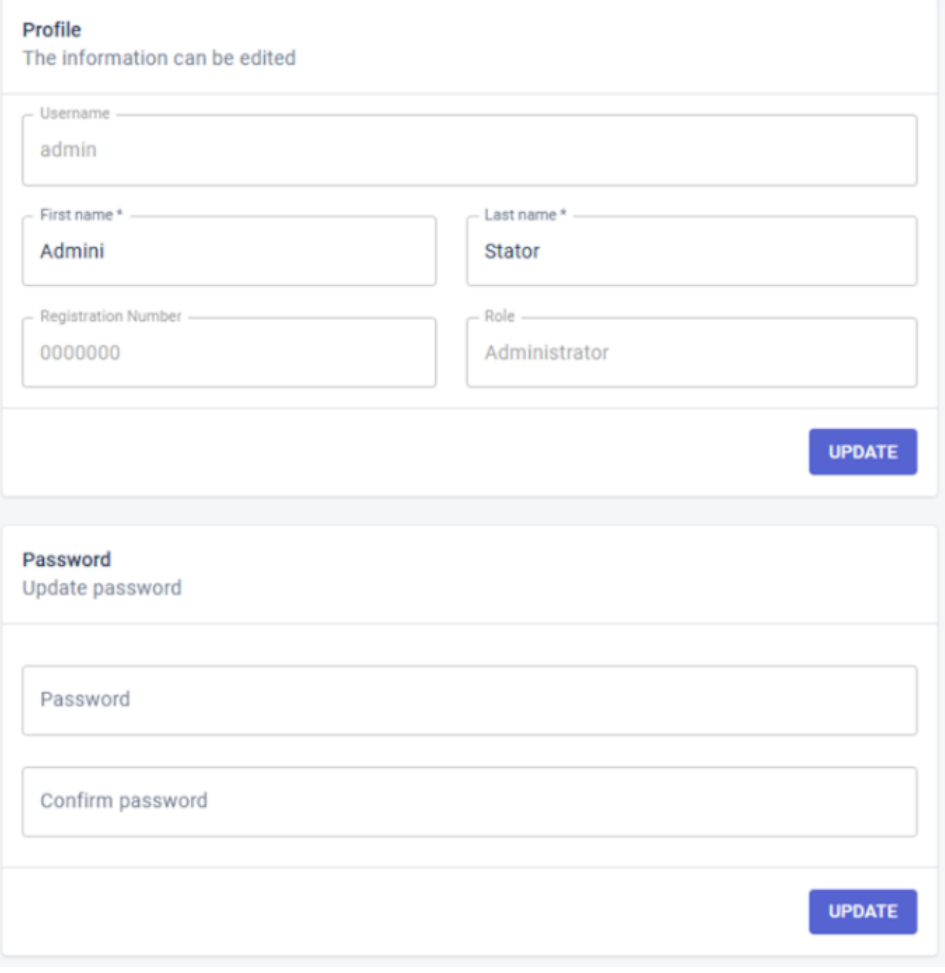
Figure 14. Personal-information tab of the Front-end